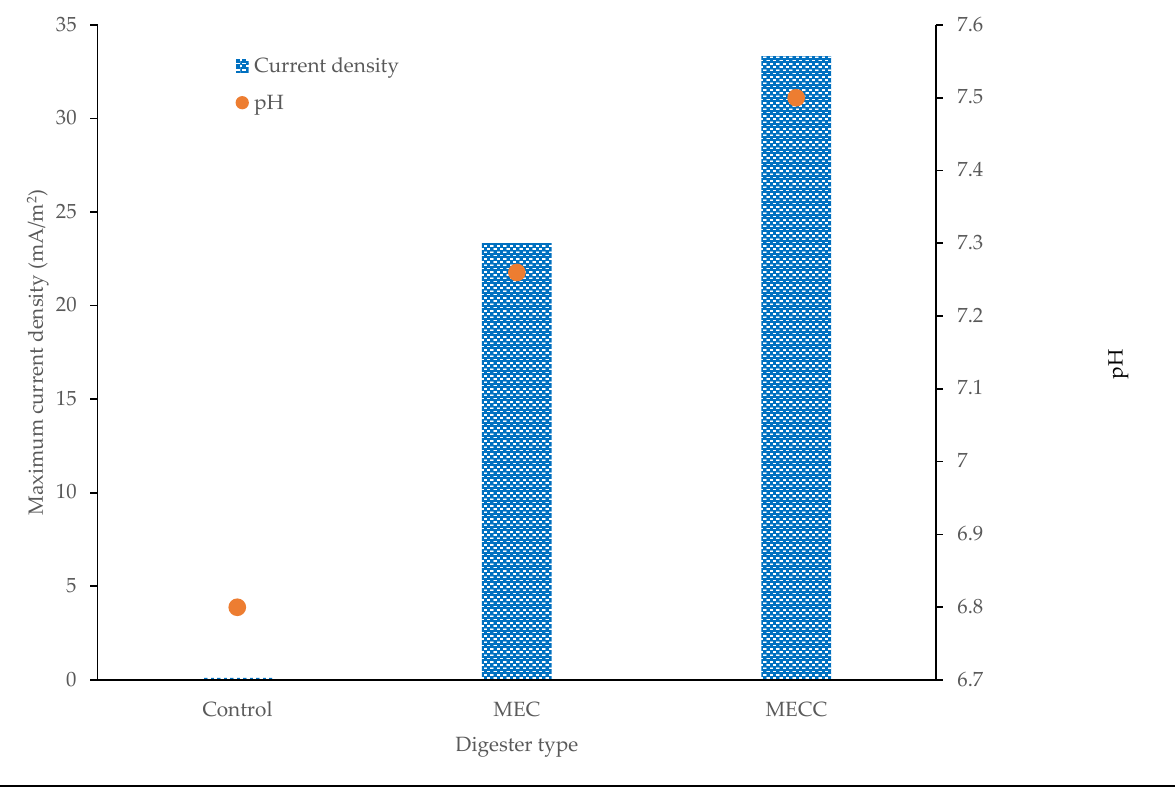
Figure 8. Effect of maximum current density on pH.